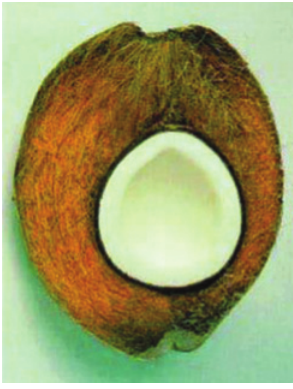
Figure 6: Coir fiber. Figure 7: Chair made of coir composites [19].